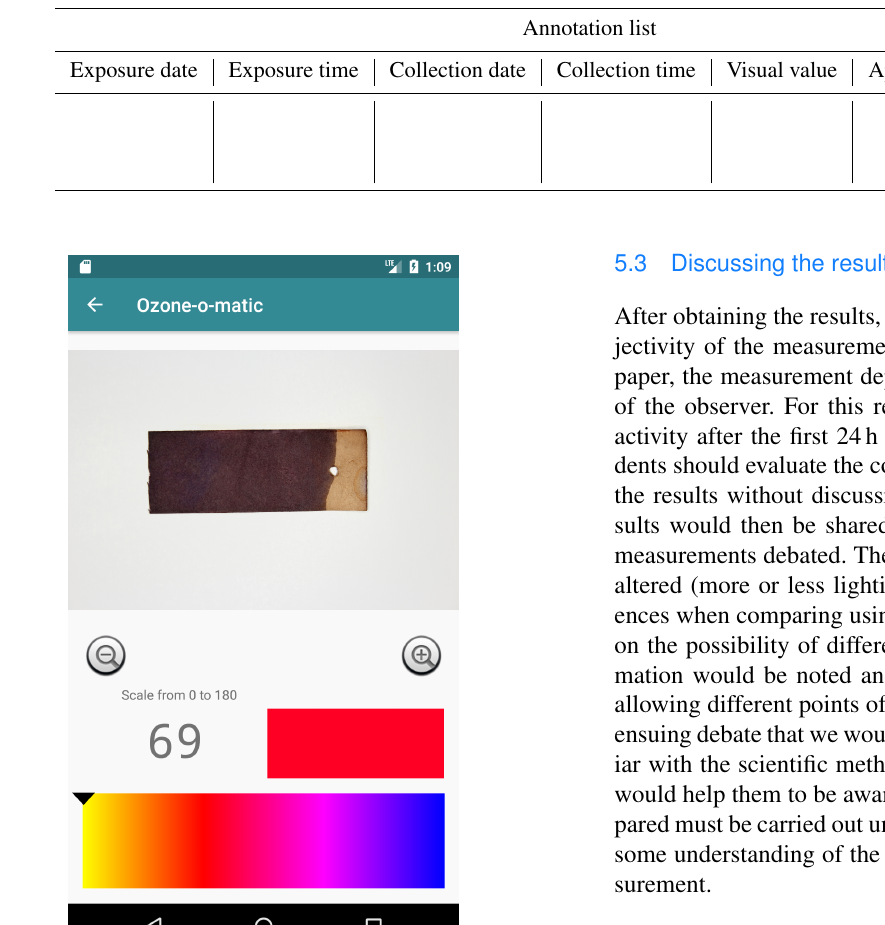
gorithm provides an output with a numerical value within that scale (Ramírez-González et al., 2020). This application (see Fig. 7) facilitates the use of the technique by